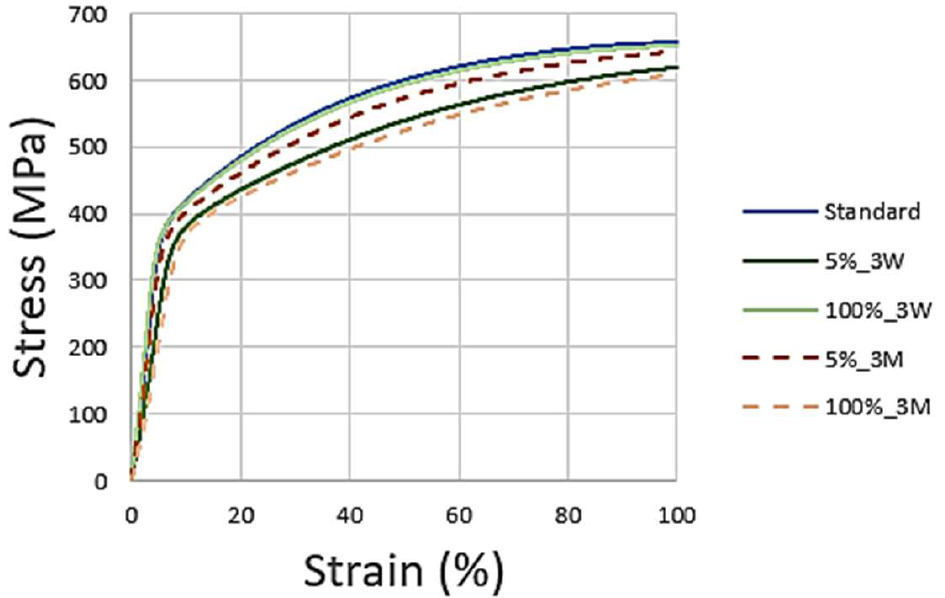
Figure 11. AISI 316L stress–strain curves after three weeks and three months. The AISI 316L presented signals of a decrease in its mechanical resistance to traction due to the NaClO effect. As expected, the standard specimen was the one with the best mechanical resistance, and the one immersed in 100% NaClO for 3 months had the worst result. The specimen at a 100% concentration for 3 weeks showed better mechanical resistance than the one at 5% for 3 months, suggesting that, in this material, the exposure time has more influence than the concentration of the